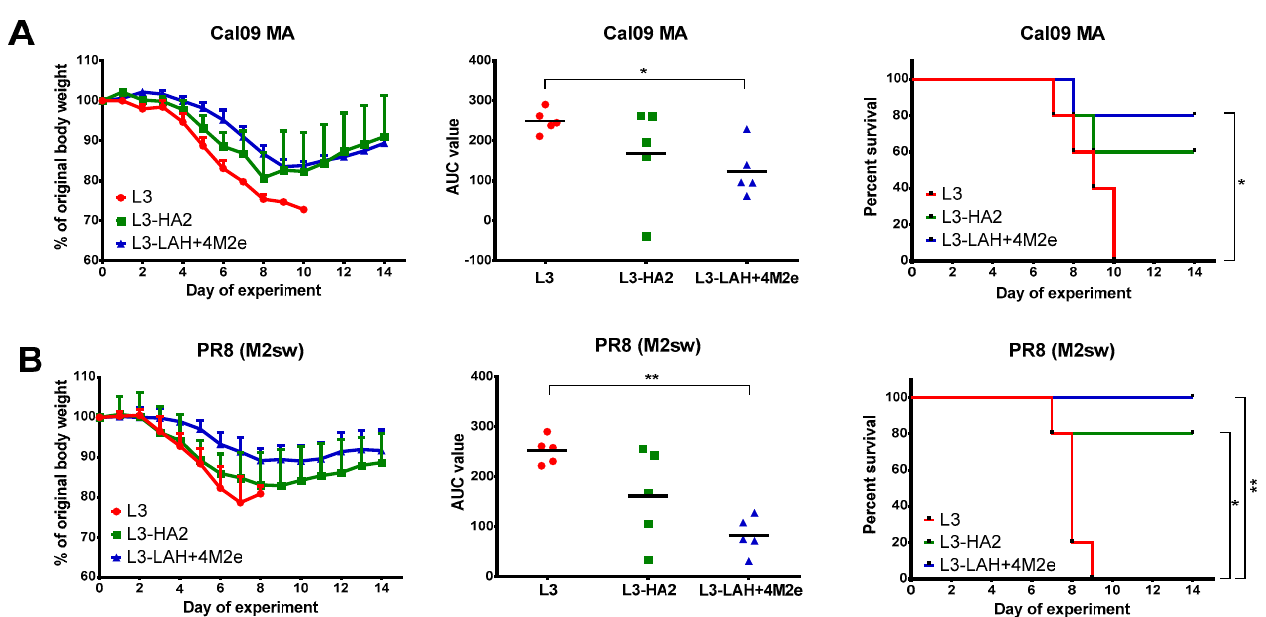
Figure 4. Protection of immunized mice against lethal influenza virus infection. Immunized mice were challenged with 3LD 50 of either Cal09 MA ( A ) or PR8 (M2sw) ( B ) virus ( n = 5 per virus). Body weight loss (left panel) and survival rates (right panel) were monitored for two weeks post-challenge. The AUC of body weight loss (middle panel) were compared by one-way ANOVA with Tukey’s post-hoc multiple analyses test. Survival rates were compared by Mantel–Cox log-rank test. *— p < 0.05; **— p < 0.01.